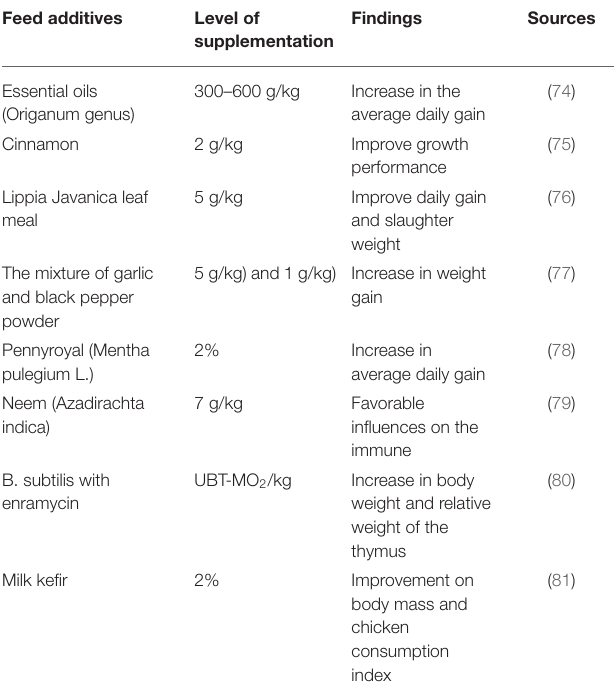
TABLE 1 | Phytogenic feed additives and ameliorative effects on broiler production. Feed